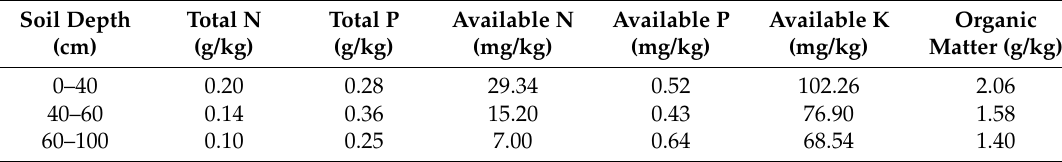
Table 2. Basic soil nutrient of the initial profile.